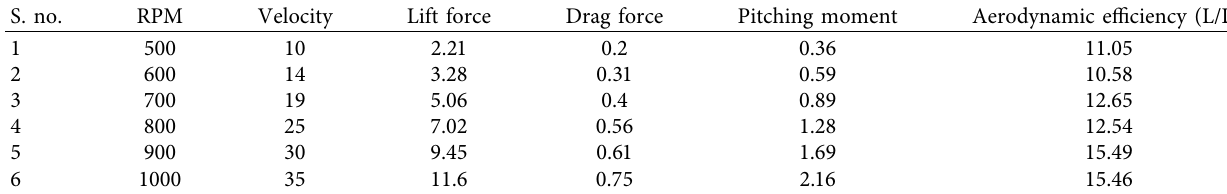
Figure 12: Maximum pressure vs. Mach Table 5: Wind tunnel readings for HH02 model.